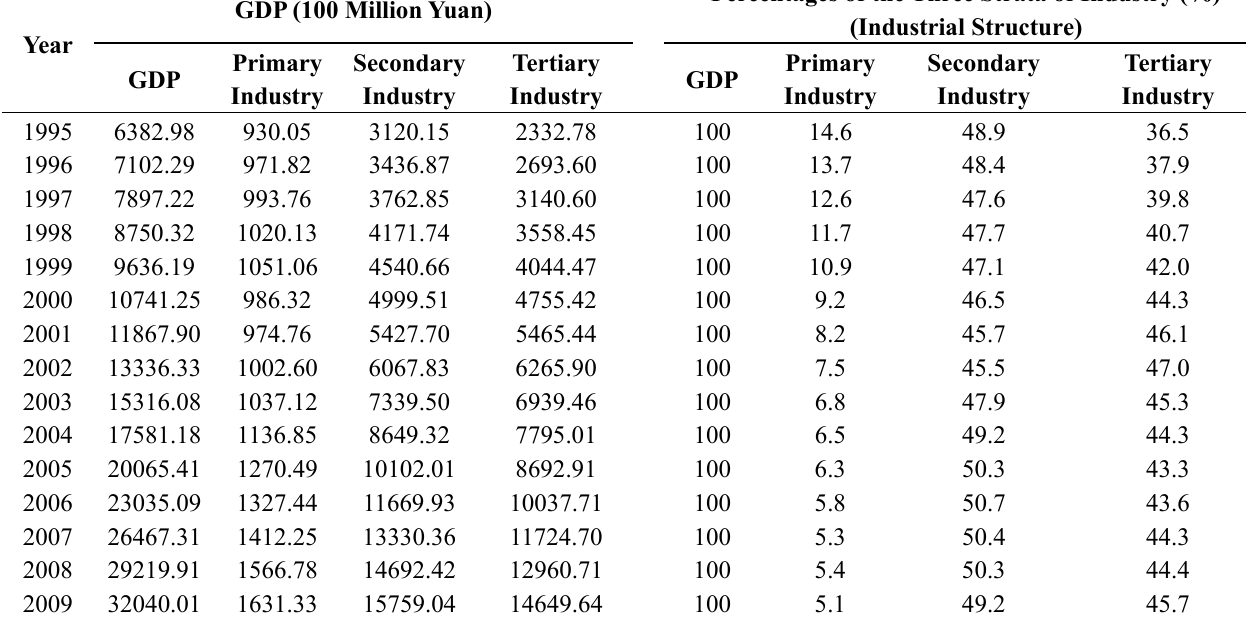
Table A4. Contribution of each decomposed factor to energy-related carbon emissions in Guangdong